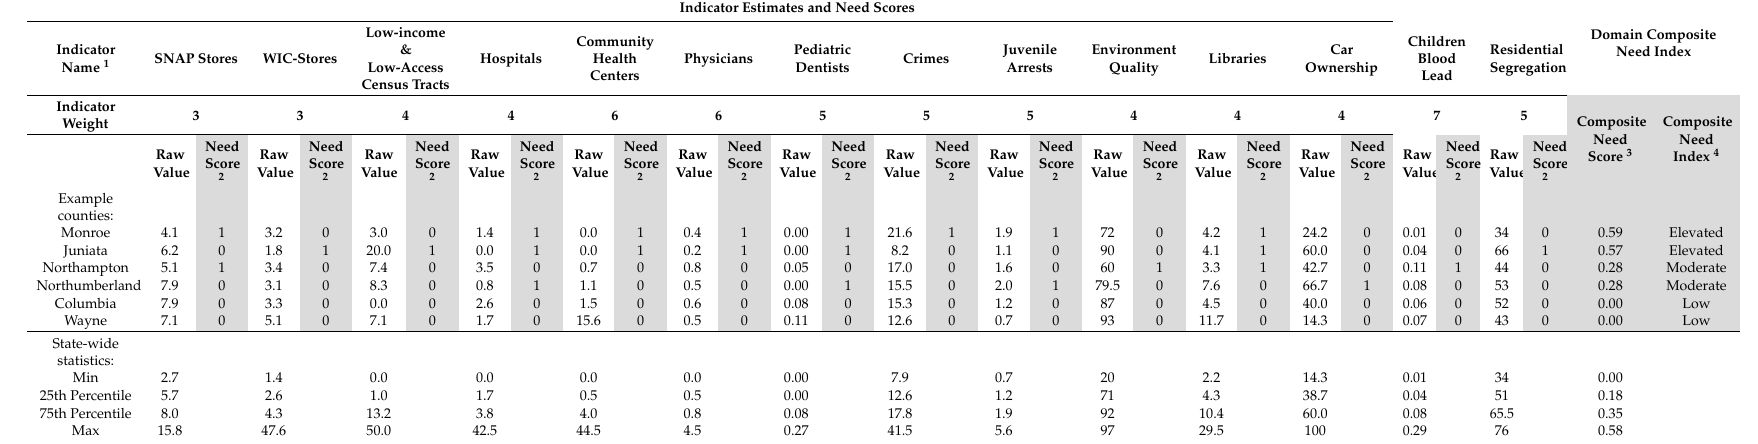
Table 3. Indicator need indices and a composite need index for the domain of Community and Environment, in 6 example Pennsylvania